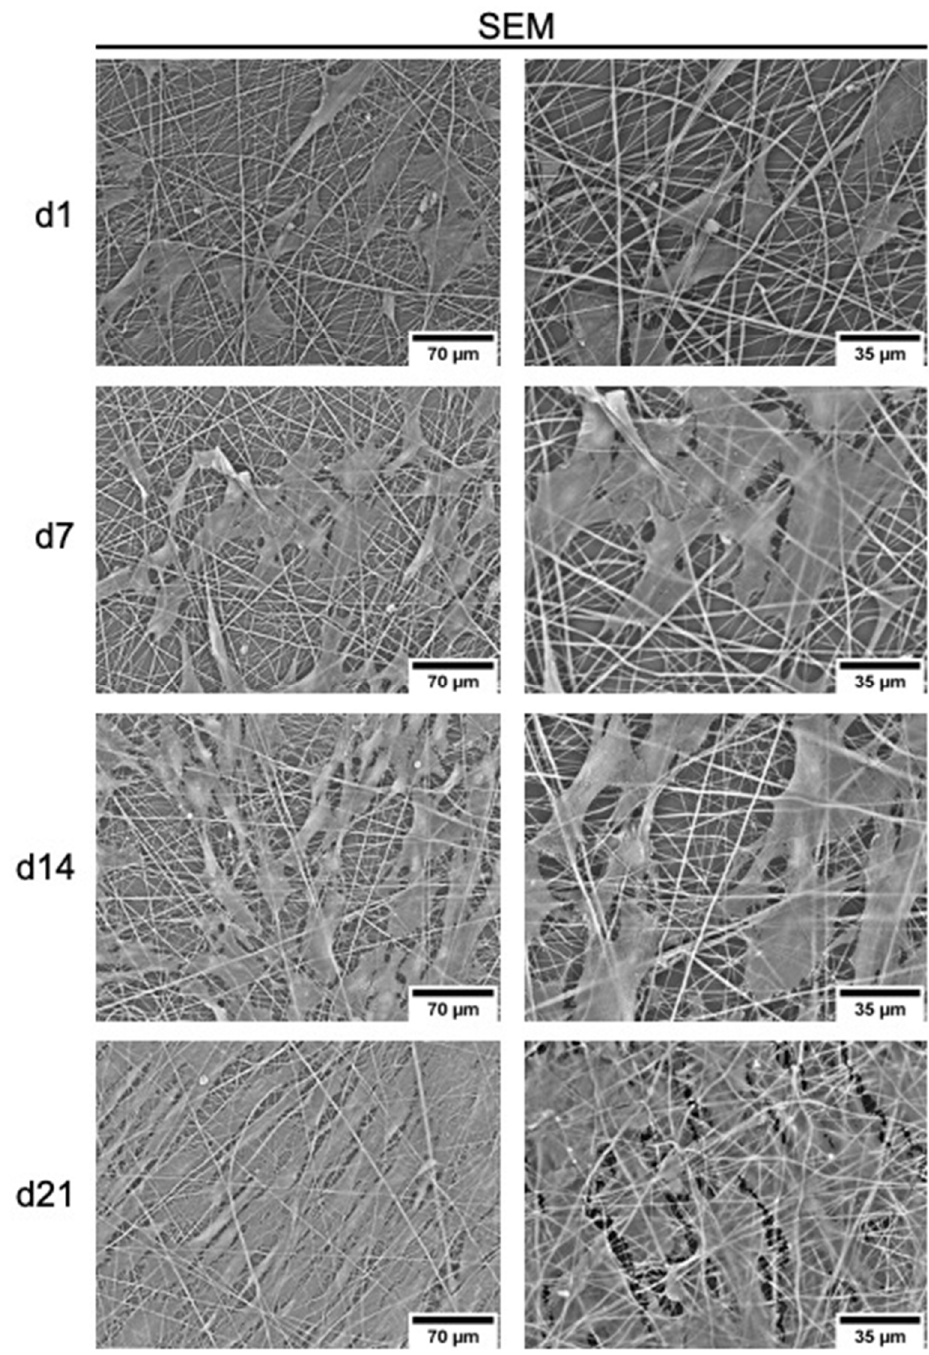
Figure 6. Representative scanning electron microscopy images of the morphology of the growth of MSCs on uncoated PCL fibers for 21 MSCs on uncoated PCL fibers for 21 days.